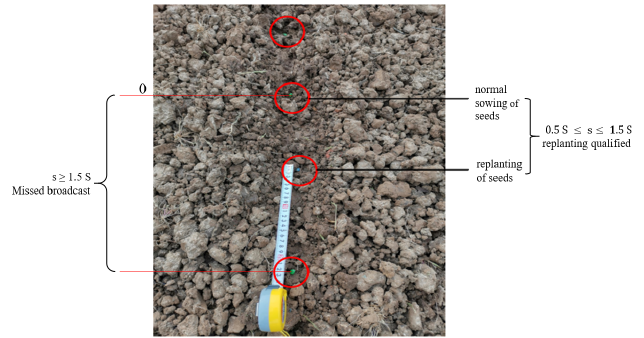
Figure 14. Test results in field.